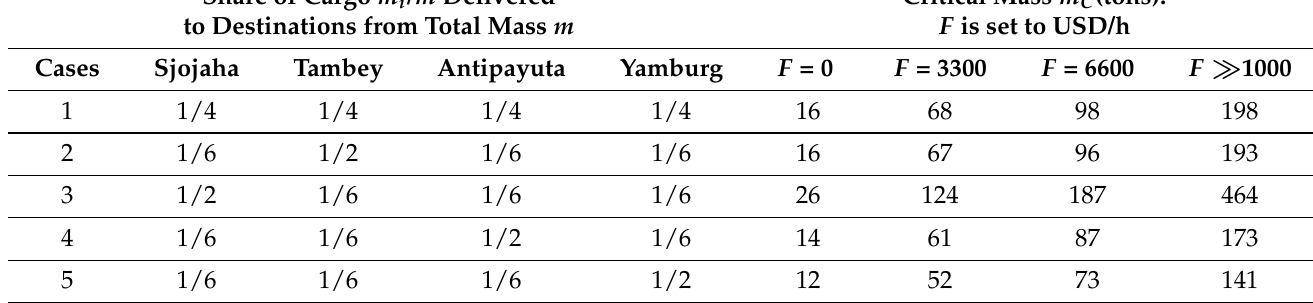
Table 1. The values of the critical mass m C for the five cases of mass ratio and the F parameter are presented, in the case of unloading the ship by helicopter to the destinations Sjojaha, Tambey, Antipayuta and Yamburg. Share of Cargo m i / m Delivered Critical Mass m C